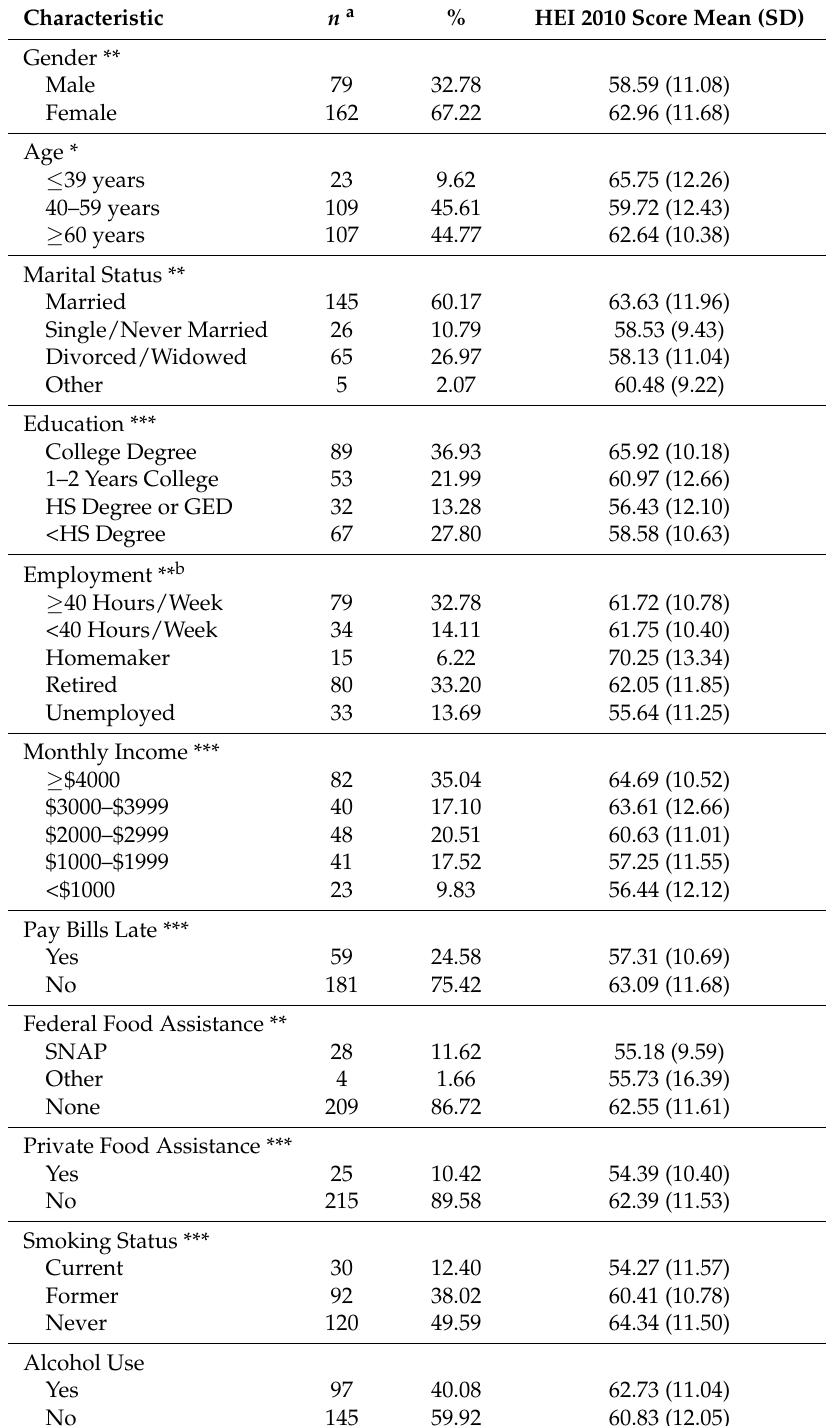
Table 1. Sociodemographic Factors and Disease-related Characteristics by Healthy Eating Index (HEI) Scores among Cancer Patients ( N =